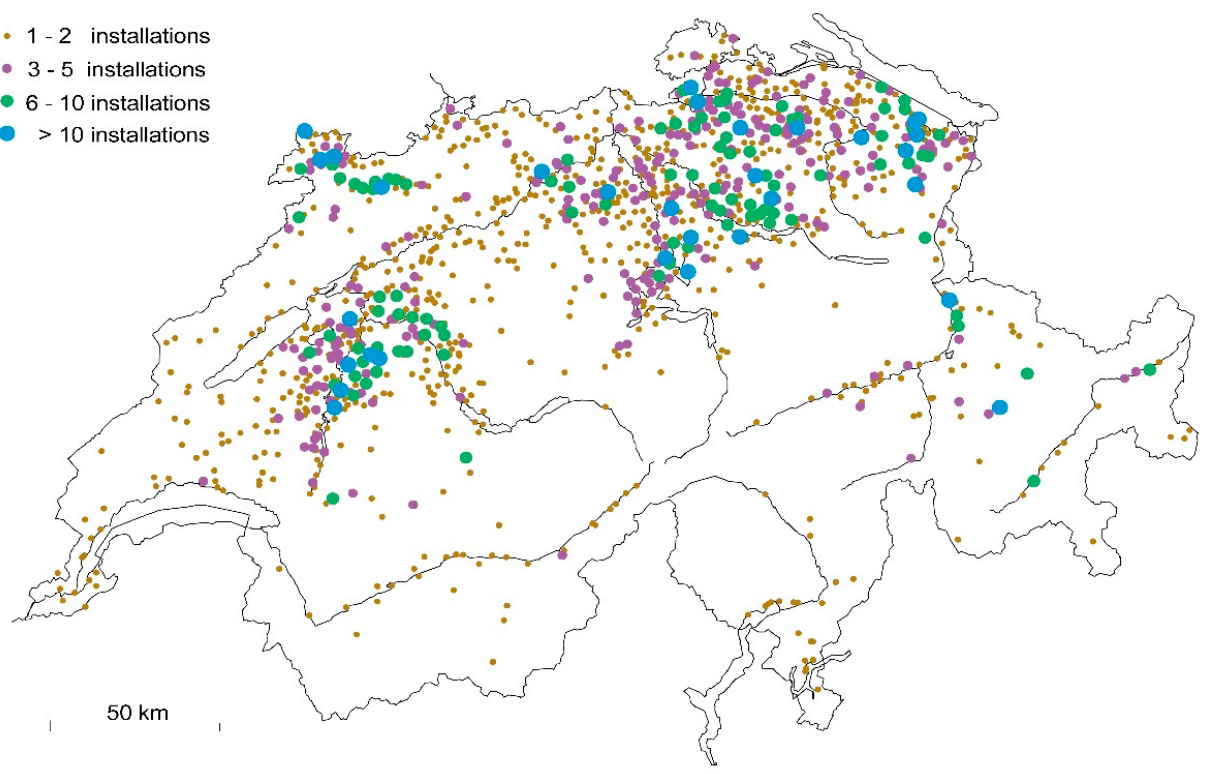
Figure 14. Location of BHE systems in Switzerland in 1990, with a total of about 4000 heating units. Data from [8] are plotted. For details and further explanations see text.